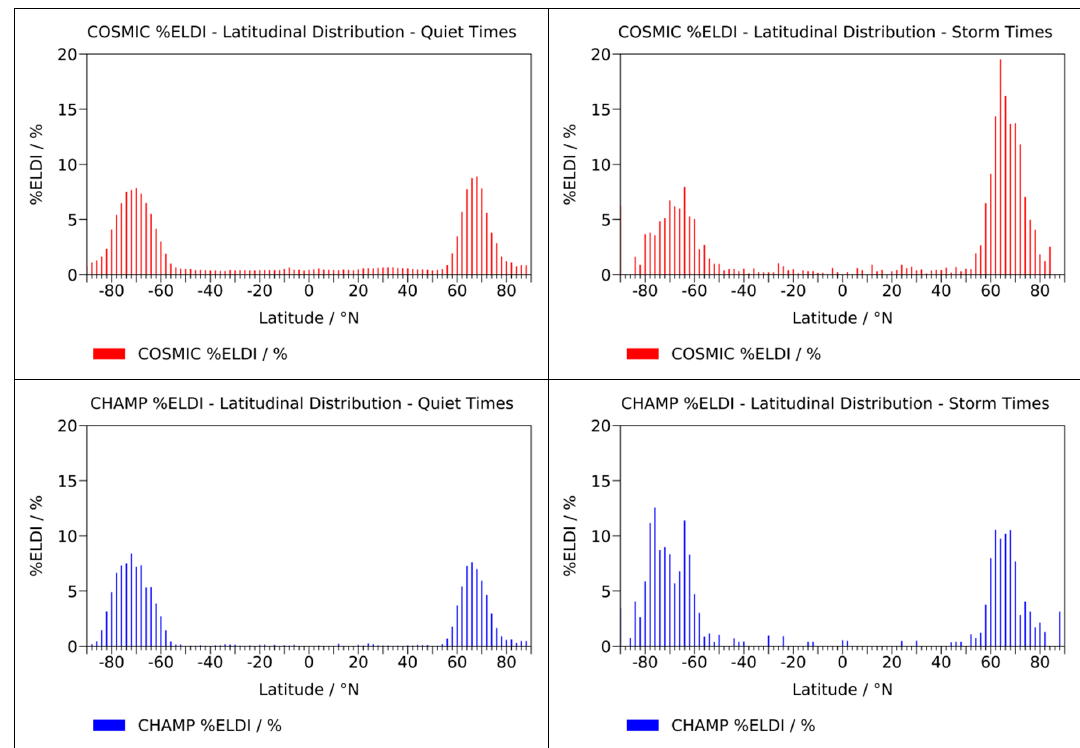
Figure 10. Latitudinal distribution of %ELDI depending on the absence/presence of geomagnetic storms. ( Top panels ) COSMIC; ( bottom panels ) CHAMP; ( left panels ) quiet times; ( right panels ) storm times.